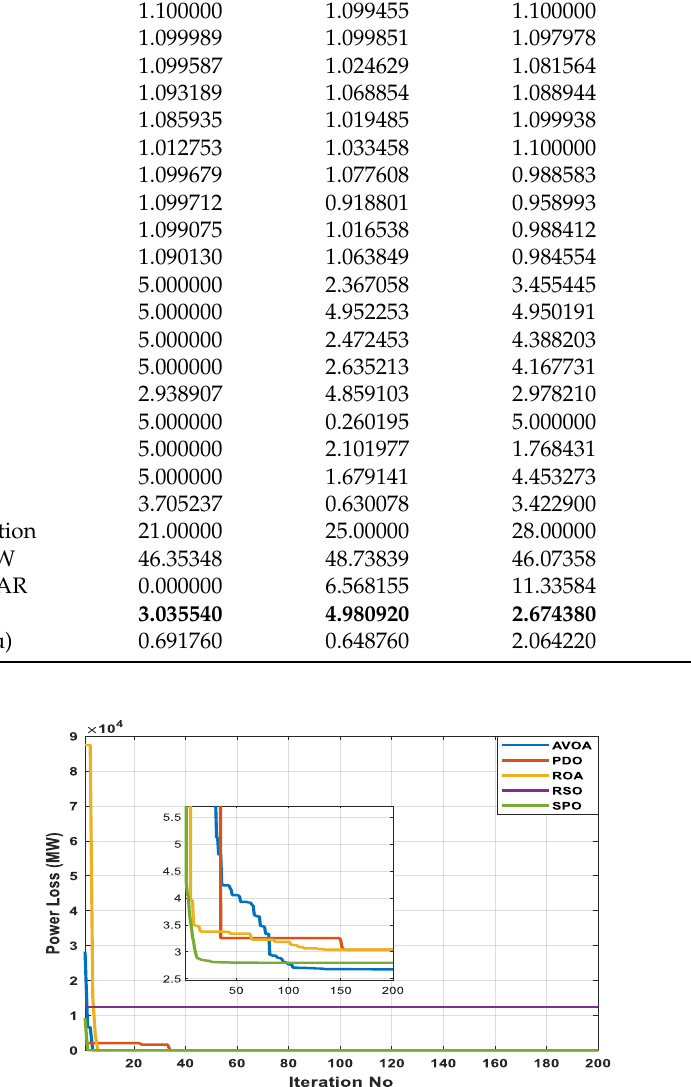
Figure 10. The AVOA voltage profile with the other compared methods for case 4. All proposed algorithms succeeded in saving the real power losses and achieving real and reactive power balance considering DGs as shown in Table 16. Also, statistical analysis is illustrated in Table 17. The performance evaluation of the proposed algorithms with a number of runs is 50. The AVOA algorithm ’ s narrow range between minimum and maximum values presents a minimum stander deviation value (0.637 pu). Additionally, it achieves a minimum mean value of computational time (20.66890 s) among other compared algorithms . Table 16. Balance of active and reactive power for proposed algorithms with case 4. Method